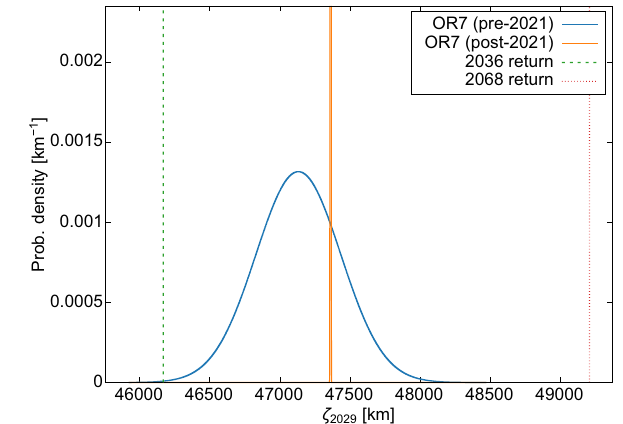
Fig. 3 Probability distribution of ζ 2029 . Probability distribution on the 2029 b -plane due to the uncertainty in the non-gravitational orbital solution, which includes the Yarkovsky effect, with (orange line) and without (blue line) including the 2021 optical and radar astrometry. The vertical dashed and dotted lines represent, respectively, the ζ coordinate value on the 2029 b -plane corresponding to a resonant return in 2036 and